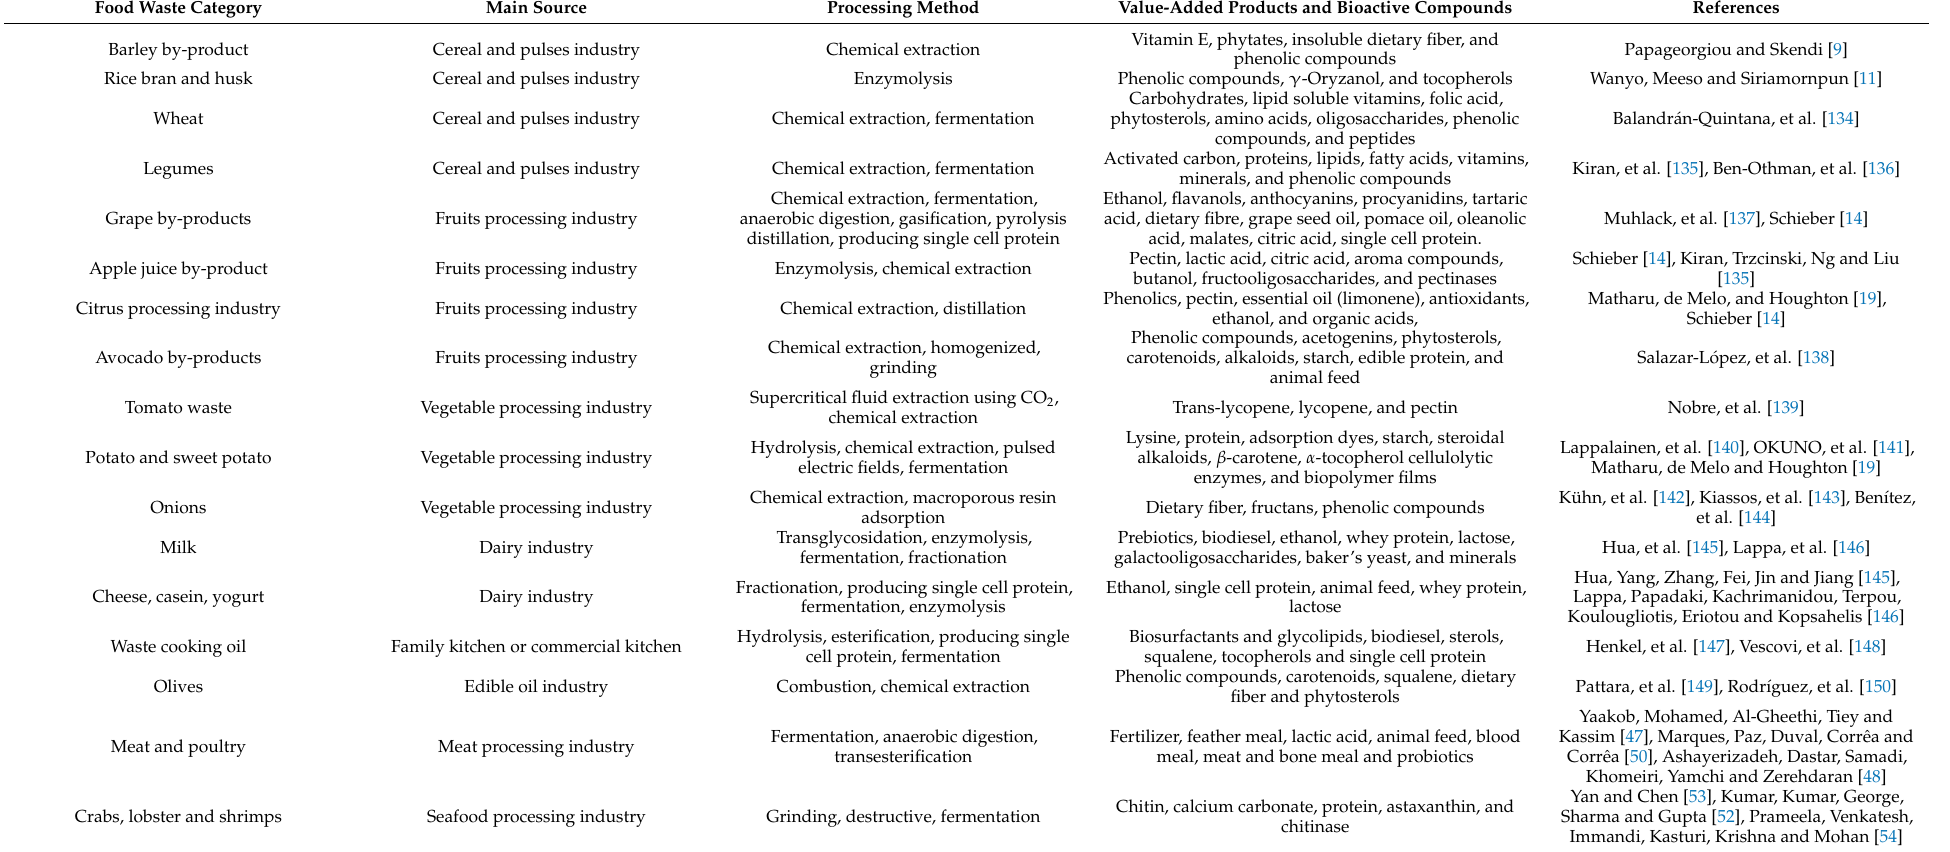
Table 2. Value-added products and bioactive compounds from different food waste